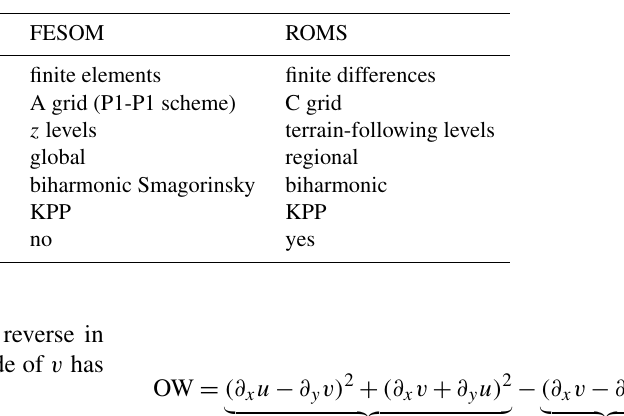
Table 1. Characteristics of the FESOM and ROMS configurations used in this